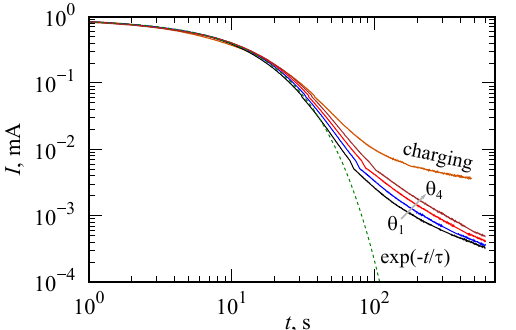
Figure 7. Charging and discharging curves | I ( t ) | in the log–log scale. Charging time θ is varied: θ = 30, 60, 120, 240 s. The initial stage is successfully approximated by an exponential function with a relaxation time τ = 12 s.